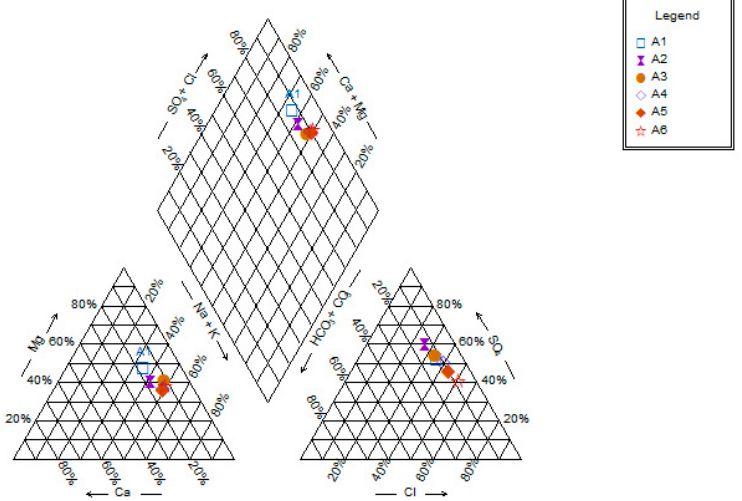
Figure 5. Piper diagram showing river water quality data for year 2013. A1—Chembarambakkam,